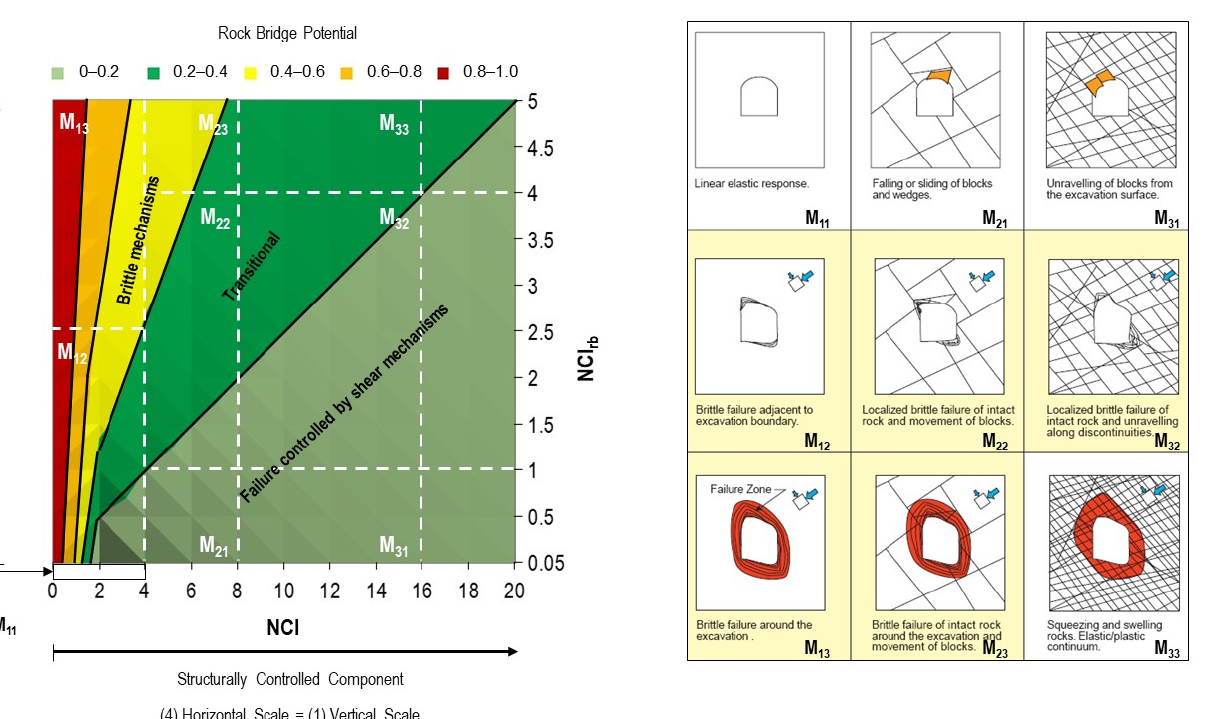
Figure 10. Example of using the concept of rock bridge potential to characterise the rock mass be ‐ haviour, defined by the proportional contribution of stress ‐ driven failure (represented by NCIrb) and structurally controlled failure (represented by NCI). Direct shear tests models from [23]. Per ‐ centages of rock mass behaviour are determined using the relative lengths across the horizontal and vertical scale (corrected for scale).